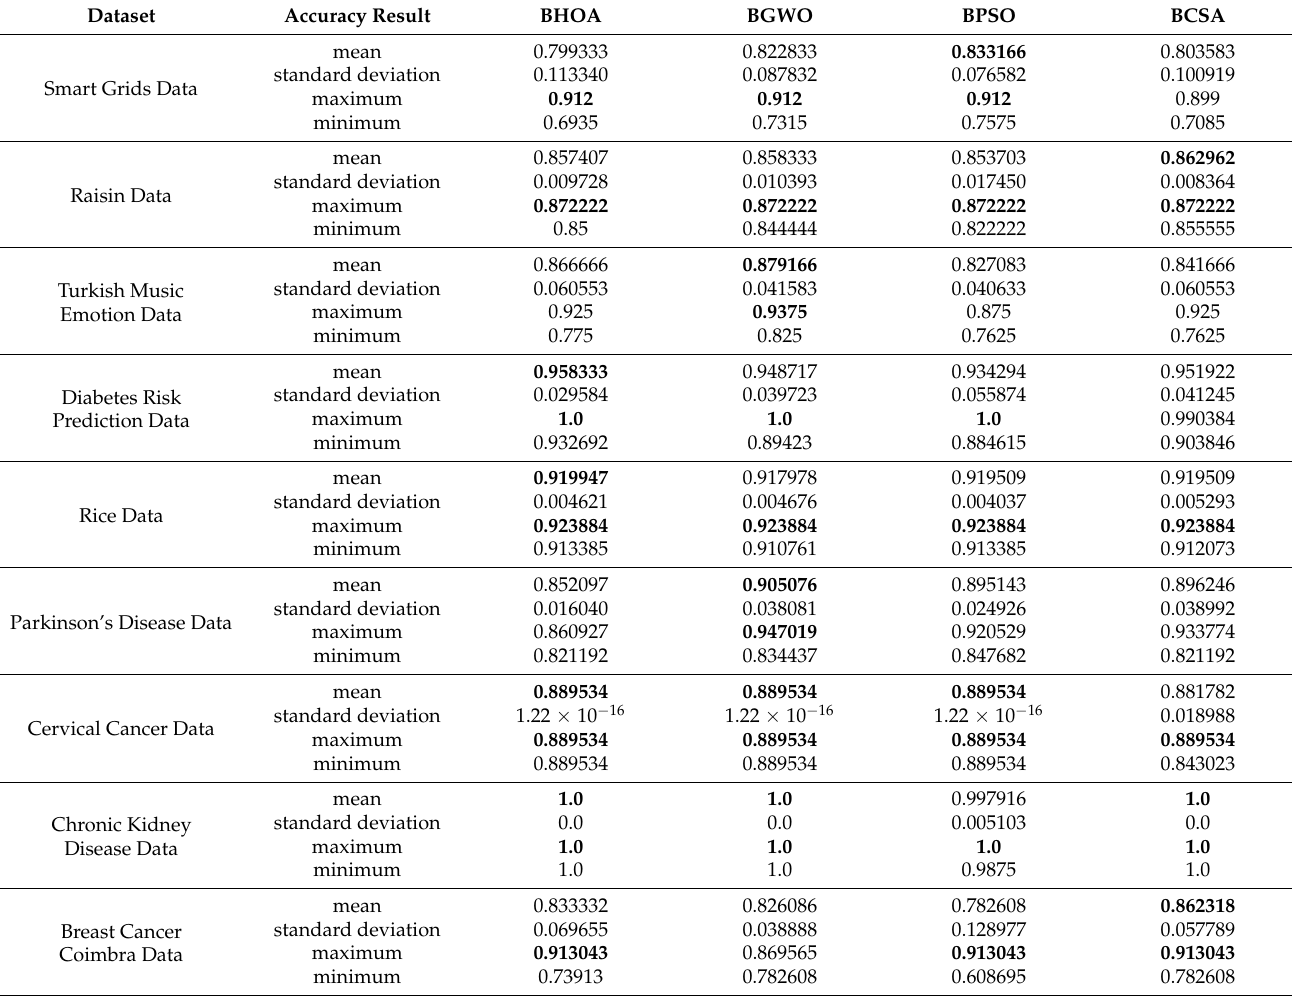
Table 16. Statistical Accuracy Results